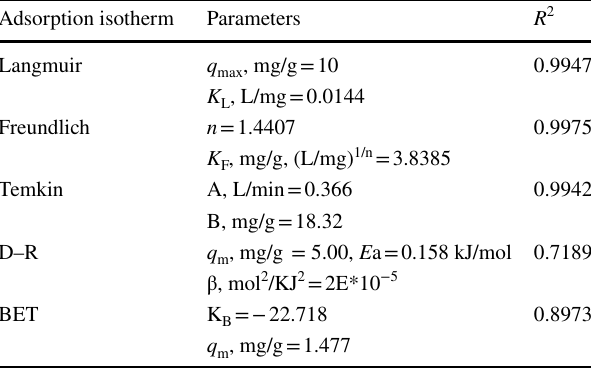
Table 2 Adsorption isotherm constants for adsorption of Ni(II)